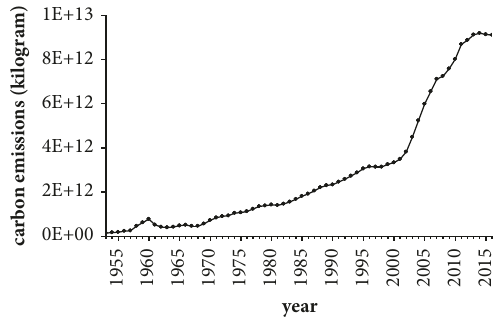
Figure 2: Time series analysis of CO 2 emissions for energy con- sumption in China during 1953–2016.